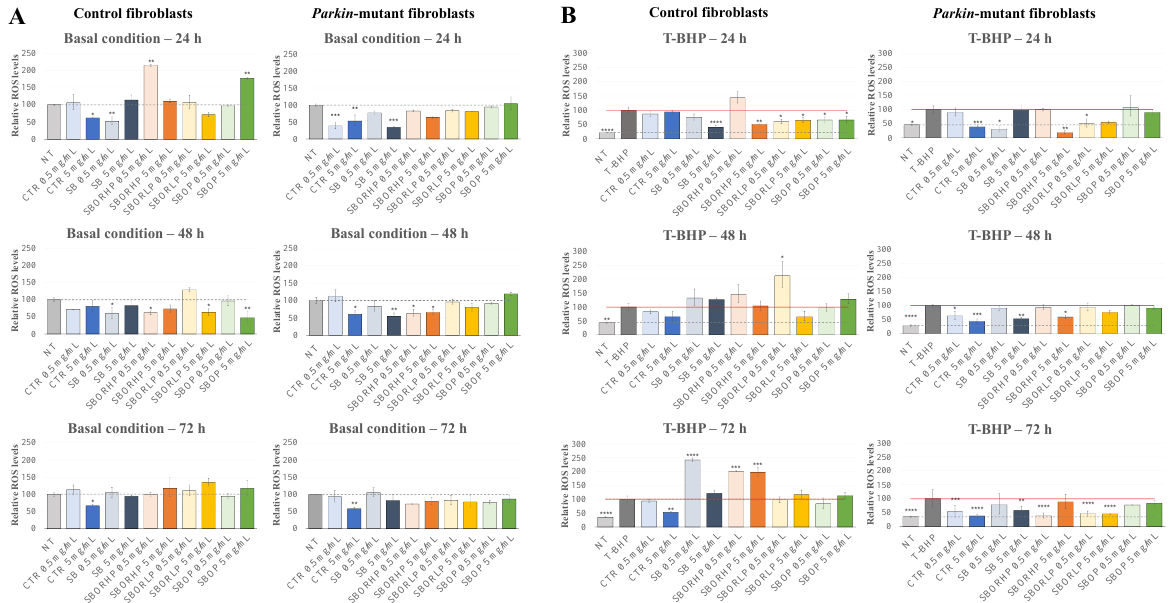
Figure 8. ROS detection performed on the control and parkin -mutant fibroblasts. Cells were treated for 24 h, 48 h, and 72 h with different samples of red onions at two different concentrations, and the ROS levels were measured by the DCF assay in the basal condition ( A ) and after exposure to the exogenous inducer of oxidative stress, T-BHP ( B ). Data were the means ± SEM from at least 3 independent experiments under each condition and were expressed as a percentage of vehicle-treated cells (dotted line) ( A ) or tert-Butyl hydroperoxide-treated cells (T-BHP) (red line) ( B ). Statistical analyses were performed using one-way analysis of variance, and mean comparisons were made using Fisher’s LSD test. * p < 0.05, ** p < 0.01, *** p < 0.001, and **** p < 0.0001.